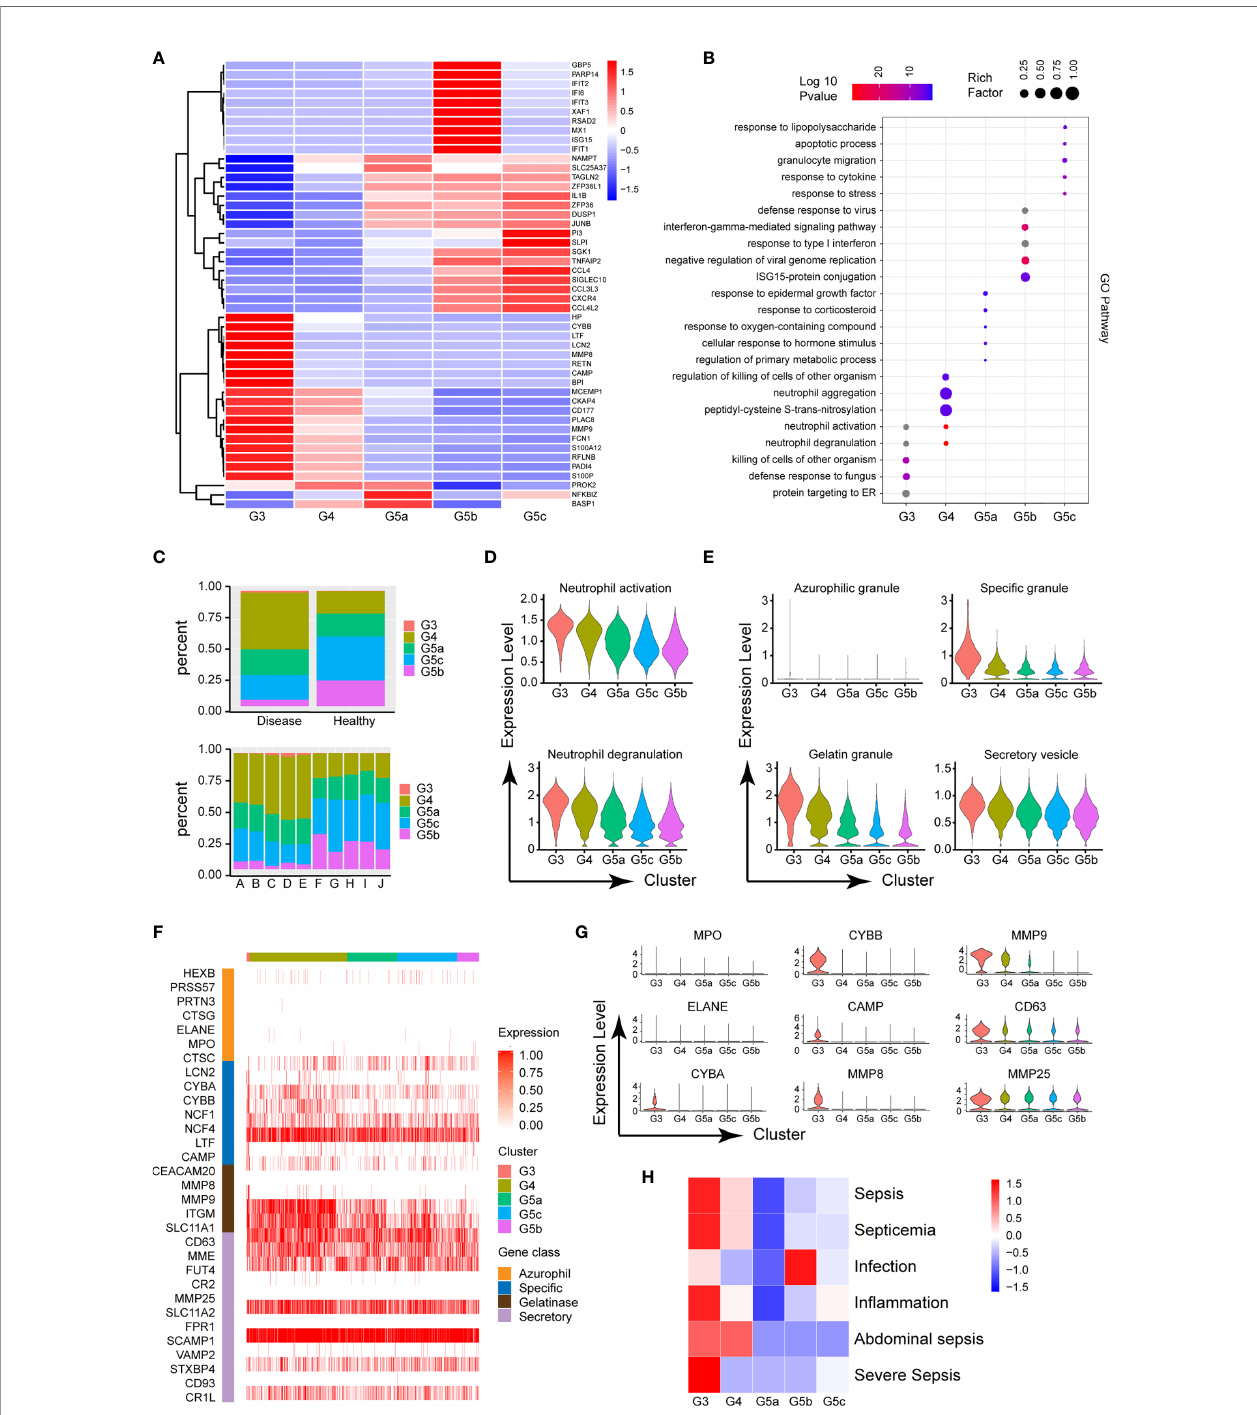
FIGURE 2 | Functional characteristics of each subgroup of PMNs. (A) Heatmap of different subsets of PMNs. Red represents high gene expression, and blue represents low gene expression. (B) GO (BP) analysis diagram of different genes in each subgroup. The size of the circle represents gene enrichment, and redder color indicates greater functional signi fi cance. (C) The proportions of fi ve subgroups in different samples. The proportions in the healthy and burned groups (above), and the proportions in each healthy control and burned patient (below). (D) Violin plot of the functional scores of activation (above) and degranulation (bottom) of fi ve subpopulations of PMNs. (E) The functional scores of four-level particles in each subgroup of PMNs. (F) Heatmap showing the expression of neutrophil granule-related genes for all PMNs. (G) Violin plot of particle-related gene expression. (H) Heatmap of the correlation between each subgroup and the disease. Red represents positive correlation, and blue represents negative